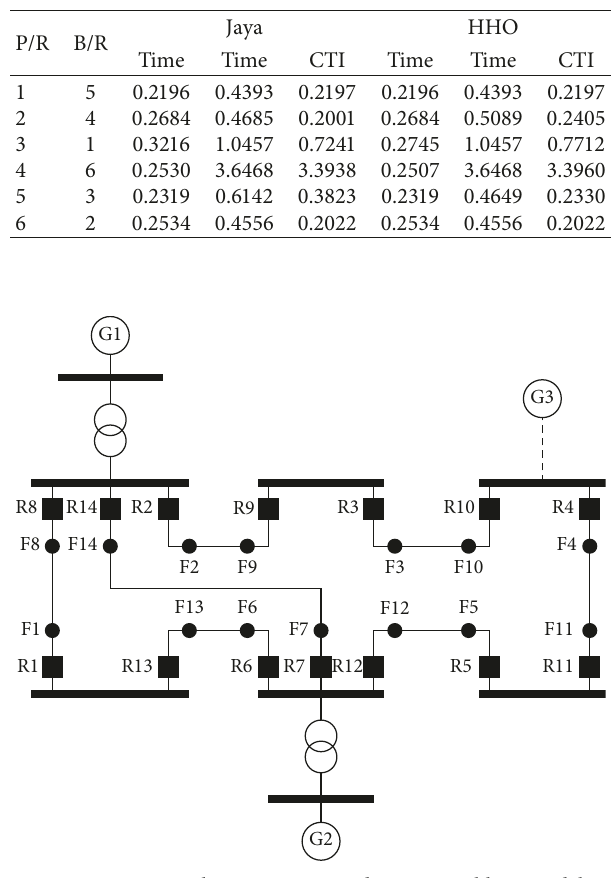
Figure 8: IEEE 8-bus DOCRs coordination problem model.